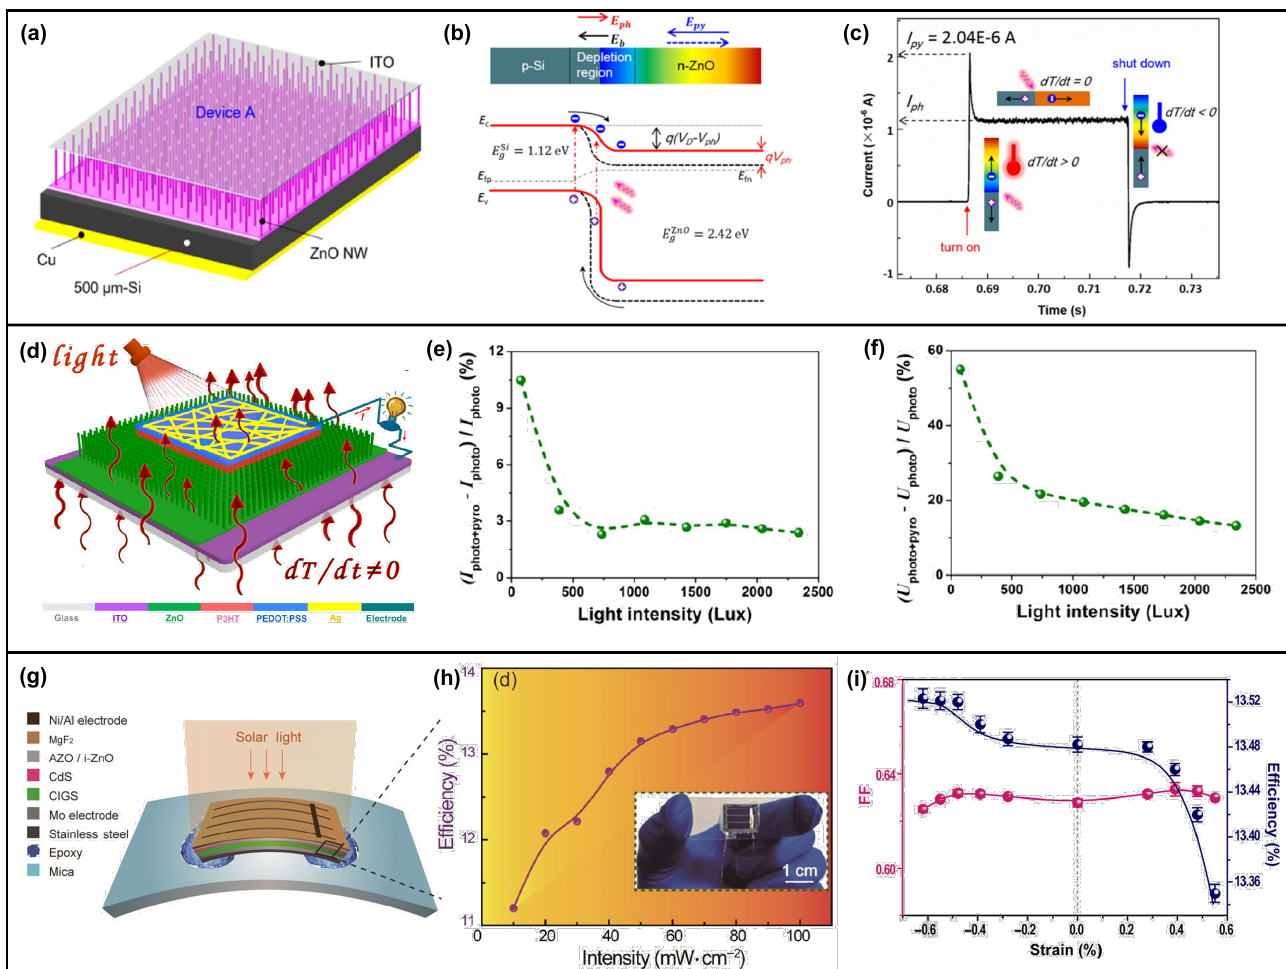
Figure 12. ( a ) Schematic image of the 500 μm p-Si/n-ZnO NW heterostructure devices; ( b ) Photogenerated holes and electrons are separated, leading to the generation of E ph ; ( c ) One typical cycle of the short-circuit I-t curve. Reproduced with permission from [91]. Copyright 2017 American Chemical Society; ( d ) Illustration of a P3HT/ZnO nanowire array solar cell demonstrating the pyro-phototronic effect; ( e , f ) Corresponding enhanced ratios of output currents and voltages by the pyroelectric effect for the P3HT/ZnO solar cell under LED illumination. Reproduced with permission from [92]. Copy- right 2016 American Chemical Society; ( g ) Schematic structure of the flexible CIGS solar cell under illumination; ( h ) Solar energy conversion efficiency of the solar cell under AM 1.5G illumination; ( i ) Strain dependence of the solar energy conversion efficiency ( η ) and the fill factor (FF). Reproduced with permission from [93]. Copyright 2018